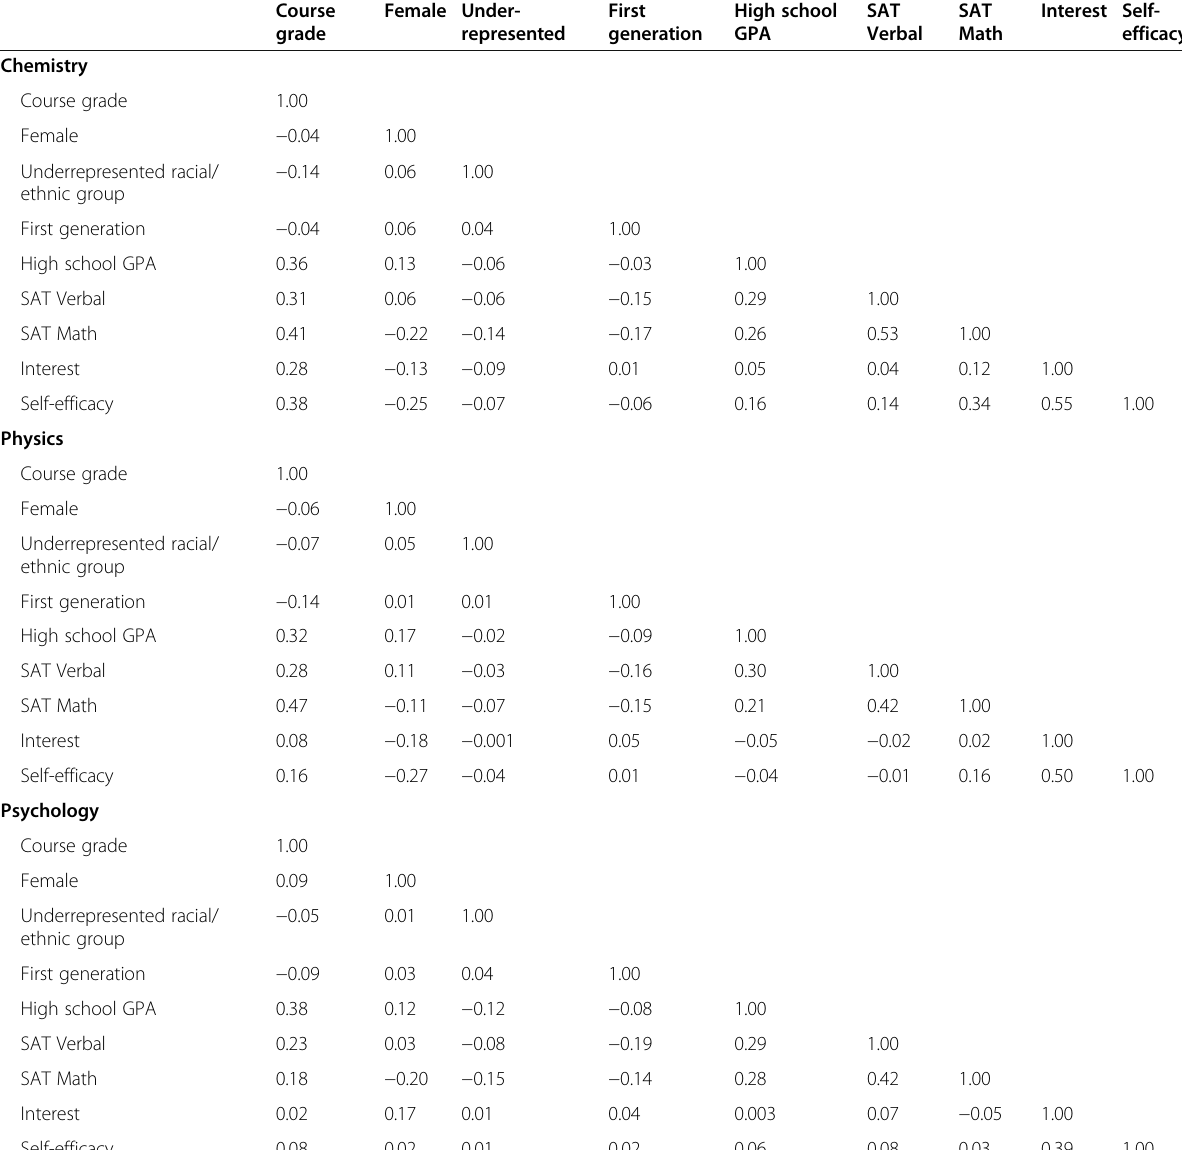
Table 4 Bivariate correlations for each variable analyzed by